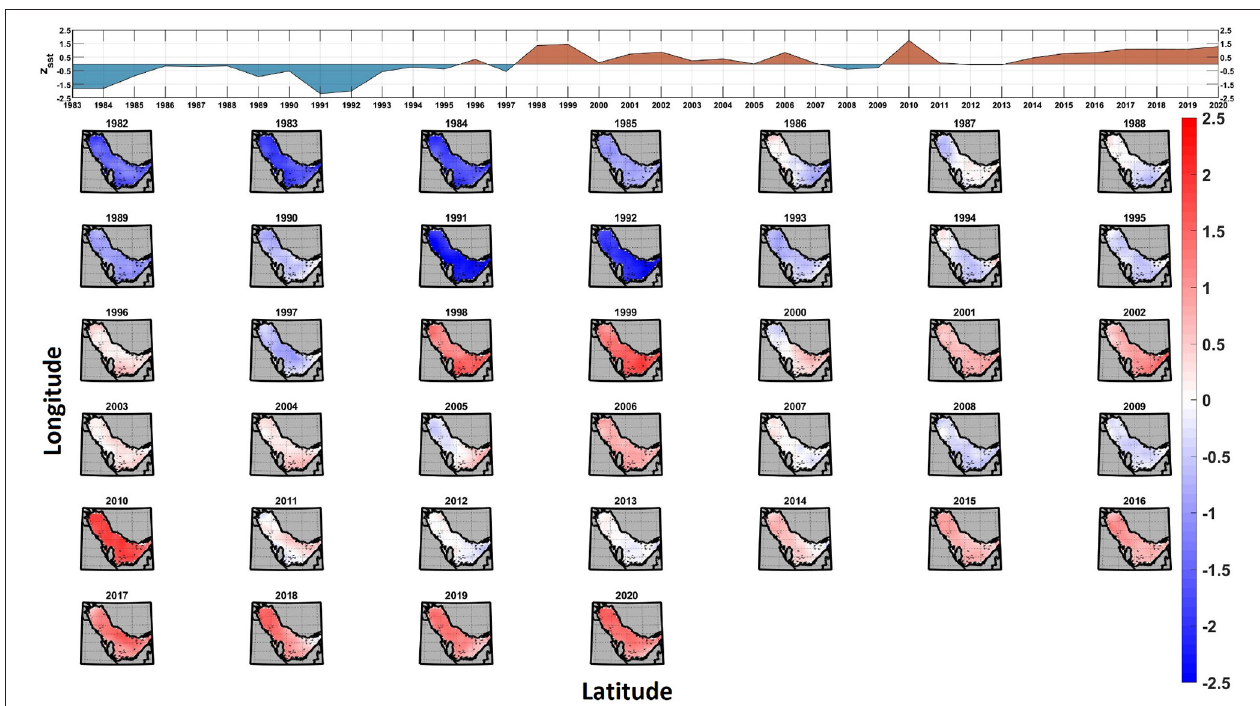
FIGURE 9 | (Top): Time series of yearly averaged SST anomalies for 1982–2020; (Bottom map) yearly averaged SST anomaly Gulf maps. SST: sea surface